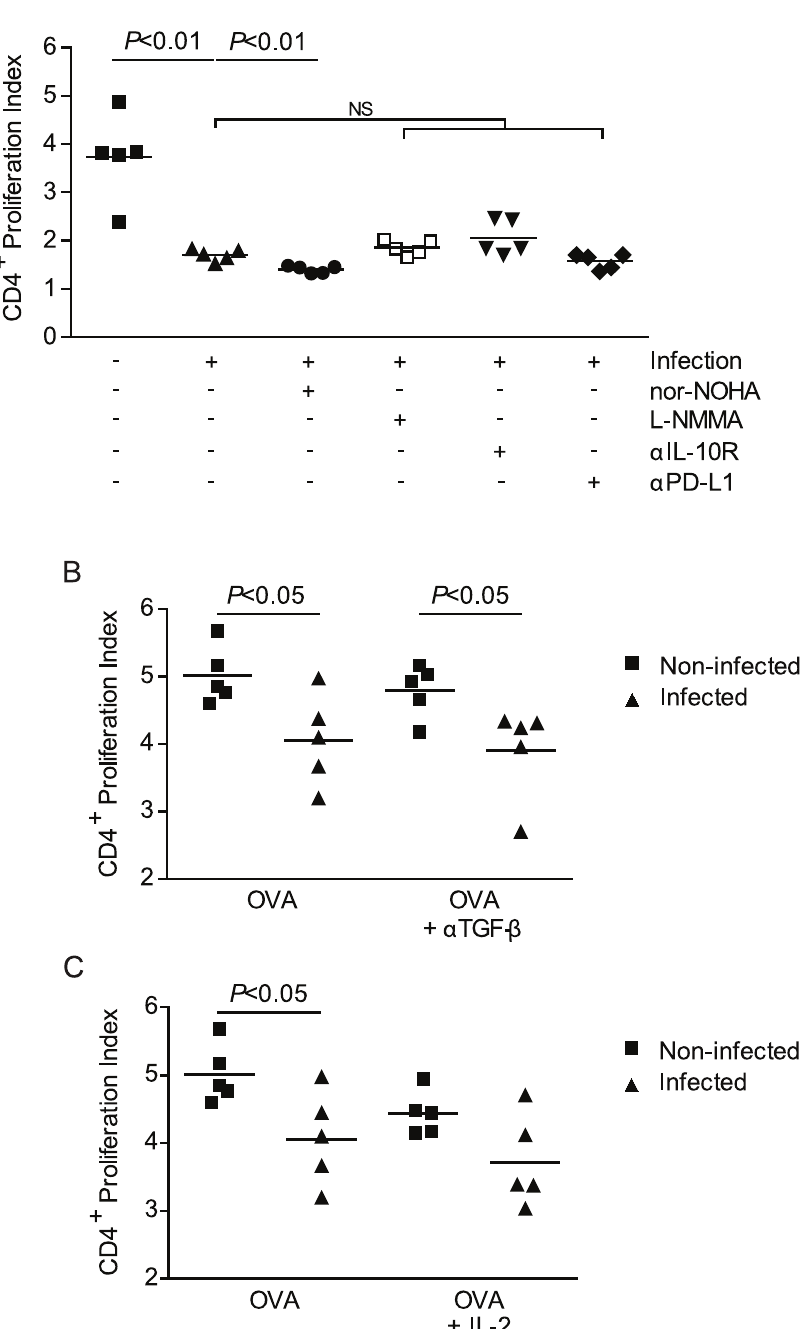
Figure 6. Impairment of T cell stimulation by pre-patent schistosome infection is independent of arginase, NOS, IL-10, PD-L1 and TGF- b . A, Splenocytes isolated from 4 week S. mansoni -infected or non-infected RAG-1 2 / 2 mice co-cultured with CFSE-stained CD4 + T cells isolated from non-infected OT-II/RAG-1 2 / 2 mice for 72 hrs with OVA peptide stimulation in the presence of Nor-NOHA, L-NMMA, anti-IL-10R or anti-PD-L1. Cells recovered from culture were stained for surface markers then analyzed for CD4 + T cell proliferation by flow cytometry. Proliferation Index was calculated. Horizontal bars represent mean of 5 independent mice. B, In a replicate, independent experiment, cells were isolated as in (A) and cultured in the presence of OVA peptide stimulation with anti-TGF- b 1, b 2, b 3 antibody (B) or recombinant IL-2 (C) and. CD4 + T cell proliferation was analyzed by flow cytometry. Horizontal bars represent mean of 5 independent mice. Data are representative of at least 3 independent experiments. Nor-NOHA, N v -hydroxy-nor-Arginine; L-NMMA, L-N G -monomethyl Arginine citrate; a IL-10R, anti-IL-10 receptor monoclonal antibody; a PD-L1, anti-PD-L1 monoclonal antibody; a TGF- b , anti-TGF- b 1, b 2, b 3 monoclonal antibody.